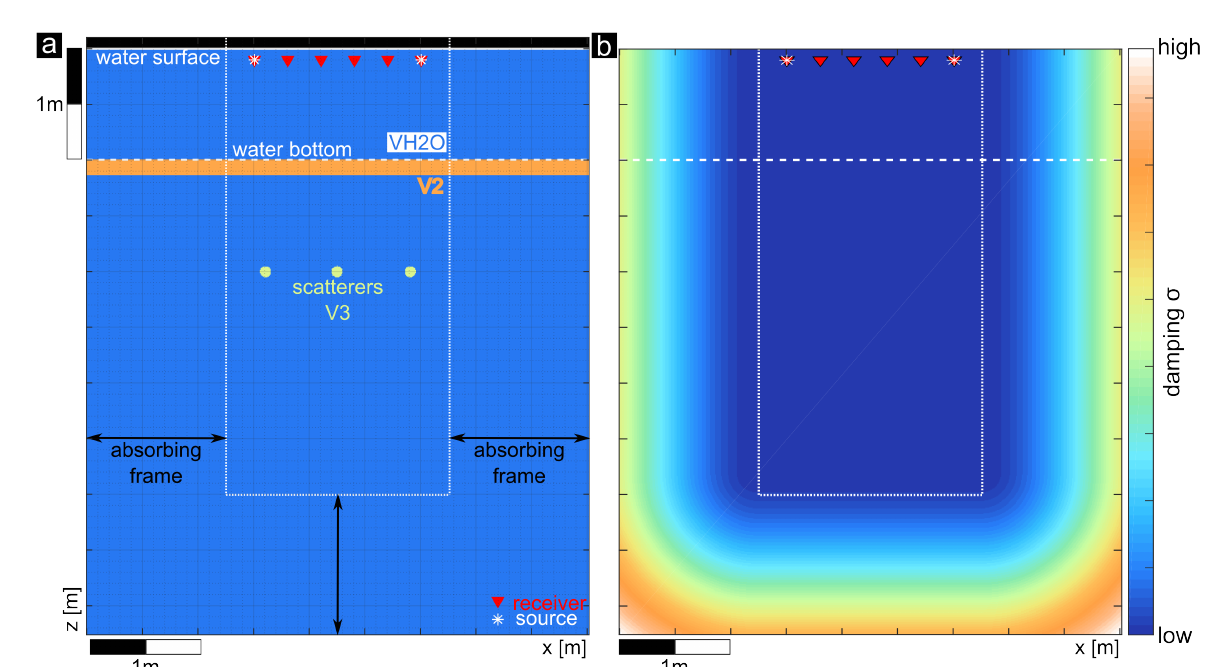
Figure 3. Schematic representation of the velocity model ( a ) and exemplary illustration of the absorbing frame ( b ) for FD modeling of the acoustic wave equation with the PingPong configuration. White asterisks show the source positions, red triangles the receiver positions. The water surface and the water bottom are marked by a white solid and dashed line, respectively. A white dotted line separates the inner model from the absorbing frame. In the velocity model ( a ), the reflection coefficient at the seafloor is represented by a small lamella of higher velocity (orange) and green circles are scattering objects with velocity v 3 . In panel ( b ), in the inner model the damping factor σ is defined by Equation (A3), in the outer part by Equation